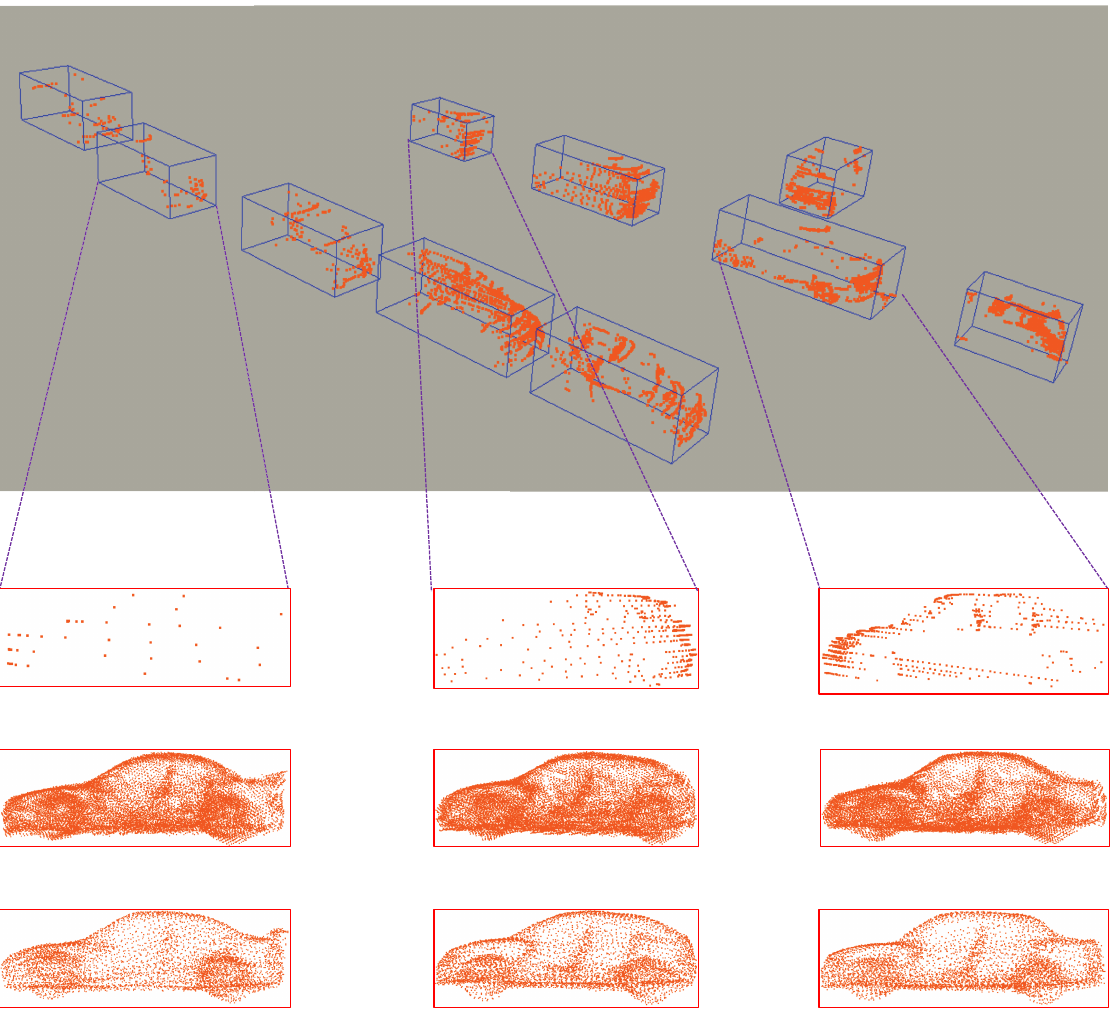
Figure 1. (Top) Real scan data collected from KITTI (Geiger et al., 2013) dataset. (Middle) Completion resutls generated by PCN (Yuan et al., 2018). (Bottom) Completion results by our proposed